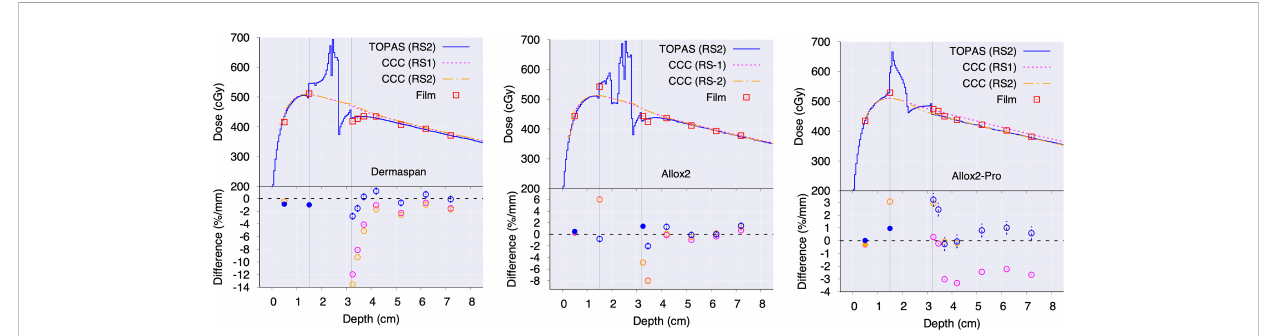
FIGURE 4 Depth-dose curves comparing the CCC (RS1 in dashed, RS2 in dotted-dashed), TOPAS (RS2 in solid) and fi lm measurements (empty squares) for: DermaSpan (A) , AlloX2 (B) and AlloX2-Pro (C) . The bottom of each panel shows the least restricted between the percentage difference (empty symbols) and distance-to-agreement ( fi lled symbols). The vertical lines limit the region occupied by the slab wax phantom.